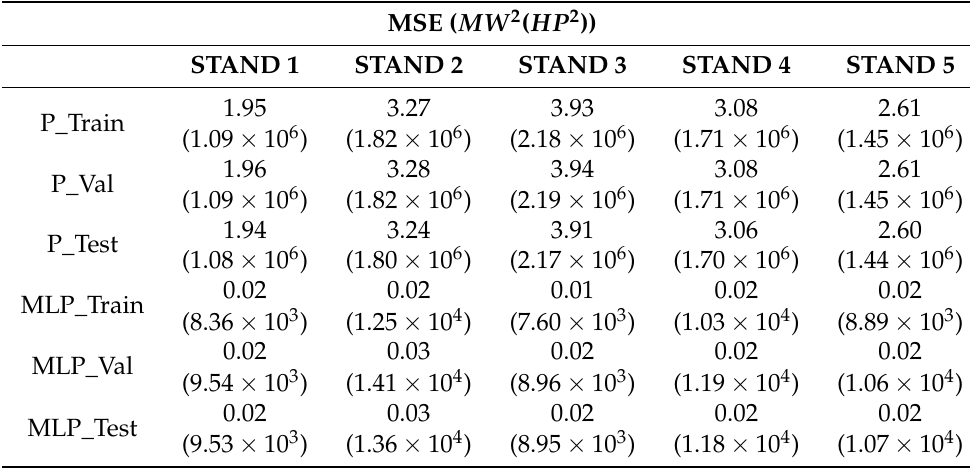
Table 15. Comparison of the motor load prediction using